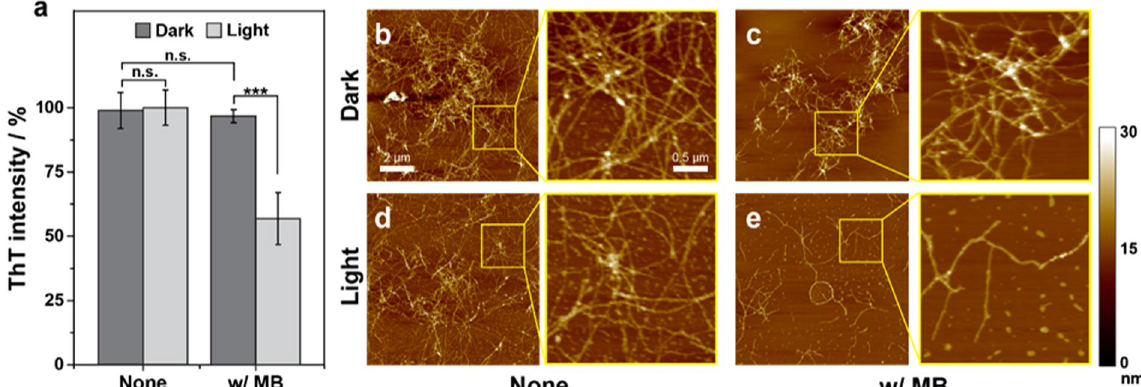
Figure 5. Disassembly of pre-formed A β 42 aggregates by photoexcited MB (10 μ M). The fully-grown A β 42 aggregates were formed by the incubation of monomeric A β 42 for 48 hrs at 30 °C. ( a ) ThT fluorescence of A β 42 aggregates after the 6 hrs of treatment with MB under dark and light conditions. ( b – e ) AFM images of fully- grown A β